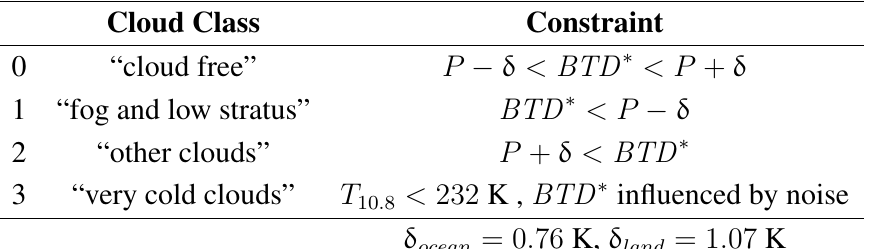
Table 3. Definition of cloud classes for a given brightness temperature difference BTD ∗